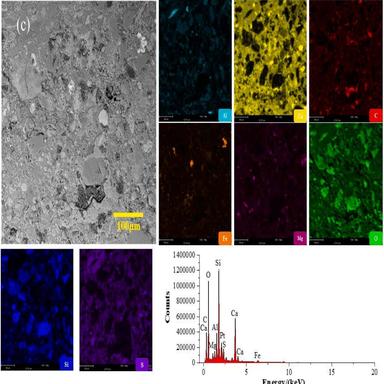
Characteristics of HPFA: (a)XRD refinement and quantitative analysis results of HPFA. (b) The particle size of HPFA. (c), (d)The SEM-EDS surface scanning results of HPFA.